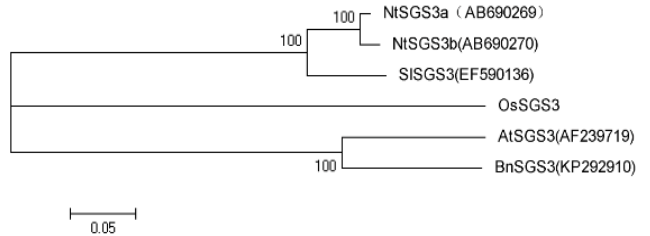
Figure 1. Phylogenetic analysis of the suppressor of gene silencing 3 in Brassica napus ( BnSGS3 ) and other published SGS3 genes involved in plant viral resistance based on the entire open reading frame (ORF) nucleotide sequence. The neighbor-joining tree was generated with the DNAMAN 6.0.4 and Mega 5.0. The significance of the branching order was assessed by bootstrap resampling of 1000 replicates. Values are indicated at the forks. The scale bar corresponds to a 5%